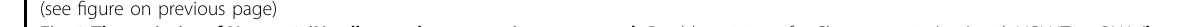
Fig. 3 The majority of Neurog2-iN cells are glutamatergic neurons. a – h Double staining of mCherry protein ( a , e ) with VGLUT2 mRNA ( b , green, pseudo-color) or Gad1 mRNA ( f , green, pseudo-color) on sections of the dorsal midbrain from WT mice that were infected with virus AAV – Neurog2/ mCherry at 30 DPI. Arrows in merged image ( d ) indicate mCherry + cells can express VGLUT2. Arrowheads in merged image ( h ) indicate mCherry + cells did not express Gad1. The nucleus was stained by DAPI ( c , g ). i – p Double staining of mCherry with GFP from VGLUT2-GFP mice ( i – l ) or GFP from Gad1-GFP mice ( m – p ) on sections of the dorsal midbrain that were infected with virus AAV-Neurog2/mCherry at 40 DPI. ( l ) and ( p ) are merged images from the mCherry signal ( i , m ), GFP signal ( j , n ), and DAPI ( k , o ), respectively. Arrows indicate mCherry + GFP + cells and arrowheads indicate mCherry + GFP - cells ( l , p ). q – t Represent mCherry ( q ) colabeled with PV ( r ) on sections of the dorsal midbrain from WT mice that were infected with virus AAV – Neurog2/mCherry at 30 DPI. Arrows in merged image ( t ) indicate mCherry + PV + cells and arrowheads indicate mCherry + PV - cells. The nucleus is stained by DAPI ( s ). u , v Statistical data indicate the percentages of colabeled cells from WT mice ( a – h , u) and transgenic mice (i – p , v ). ( a – h ) Confocal images 40x (oil); ( i – t ) Confocal images 20x. Scale bars: 25 μ m ( a – h ) and 50 μ m ( i – t